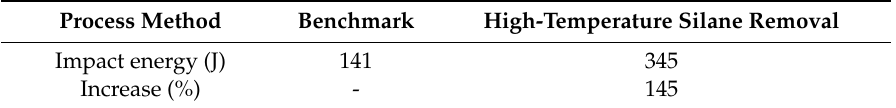
Table 6. The comparisons of the maximum impact energy for benchmark and high-temperature silane removal carbon-fiber-reinforced cement specimens.